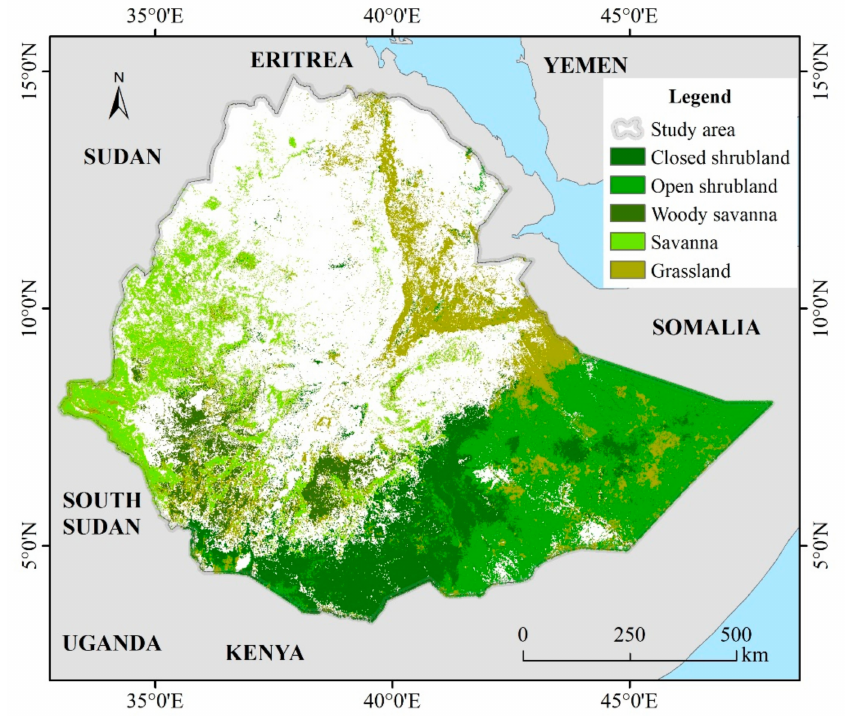
Figure 3. Grassland cover distribution extracted from remote sensing images in Ethiopia.